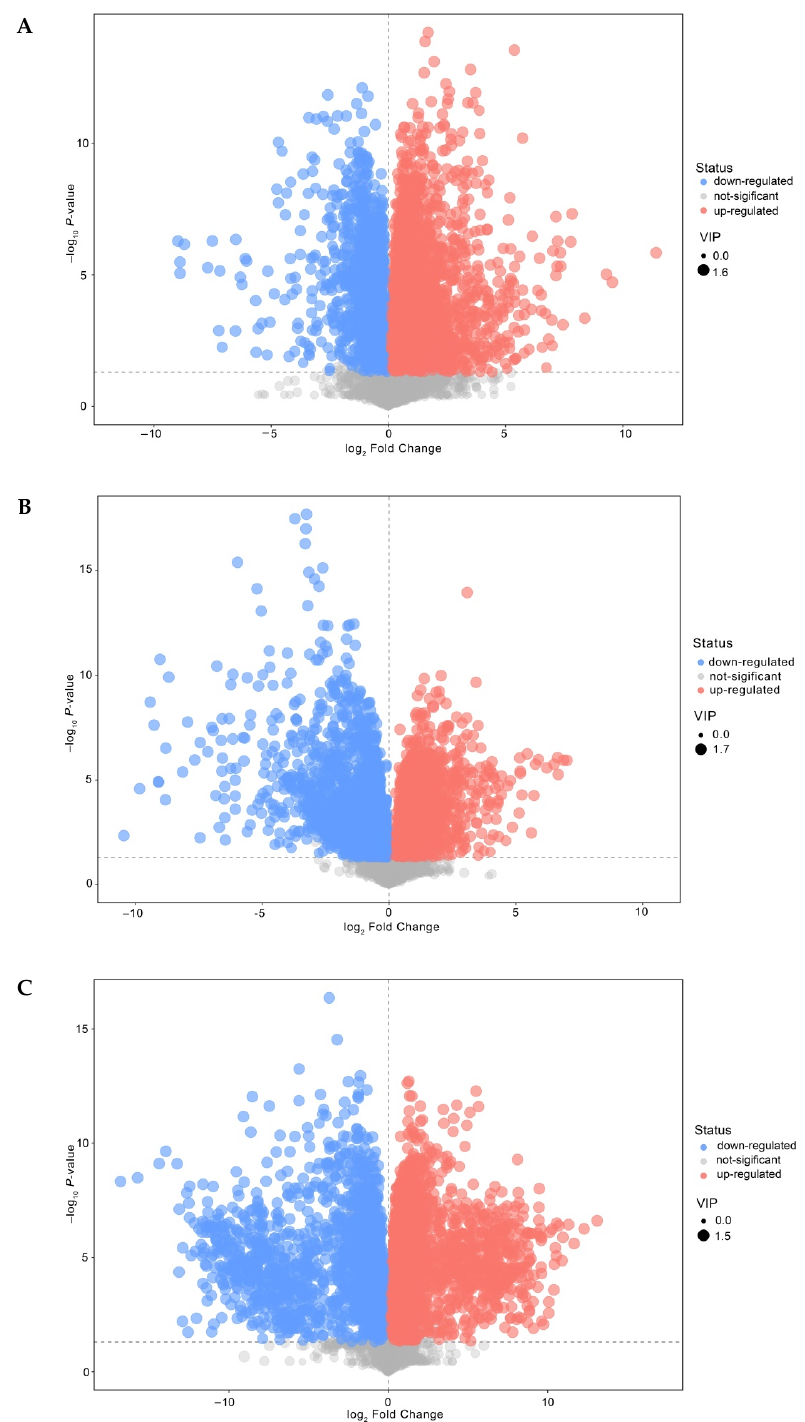
Figure 6. Volcano plot of OPLS-DA model for different groups. ( A – C ) are volcano plots of M1 vs. S1, M20 vs. S20, and M40 vs. S40. The size of the points represents the VIP value according to OPLS-DA. The abscissa represents the multiple change of the group compared to each substance, and the ordinate represents the p -value of the Student’s t -test. The scattered colors represent the final screening results. Metabolites that are significantly upregulated are shown in red, metabolites that are significantly downregulated are shown in blue, and metabolites that are not significantly different are shown in gray. Abbreviations: M, mixed-fermentation cheese; S, single-strain-fermentation cheese. Numbers 1–40 represent different ripening times (in